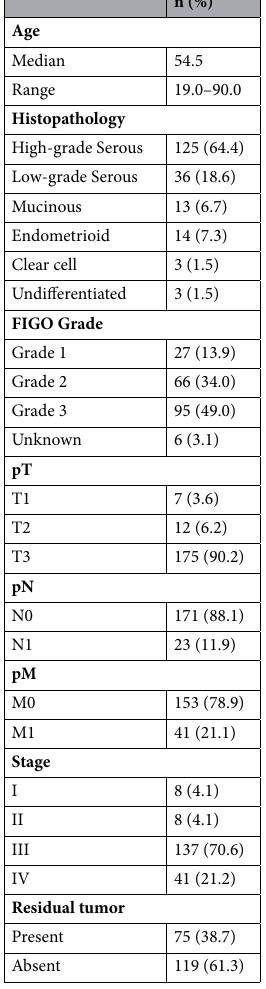
Table 1. Clinico-pathological variables for the patient cohort (n =